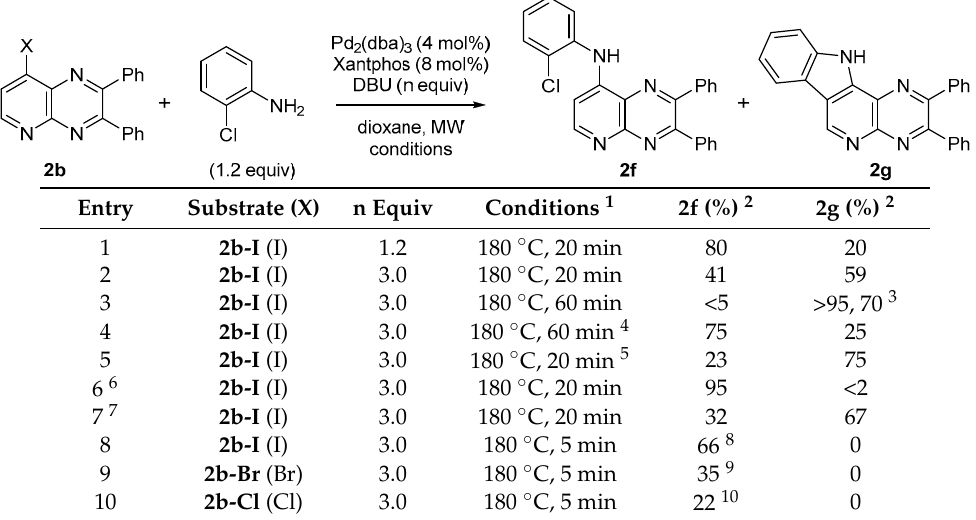
Table 3. Study of the conversion of the 8-halogenated 2,3-diphenylpyrido[2,3- b ]pyrazines 2b into 2,3-diphenyl-11 H -pyrazino[2 (cid:48) ,3 (cid:48) :5,6]pyrido[4,3- b ]indole ( 2g ) under MW irradiation.